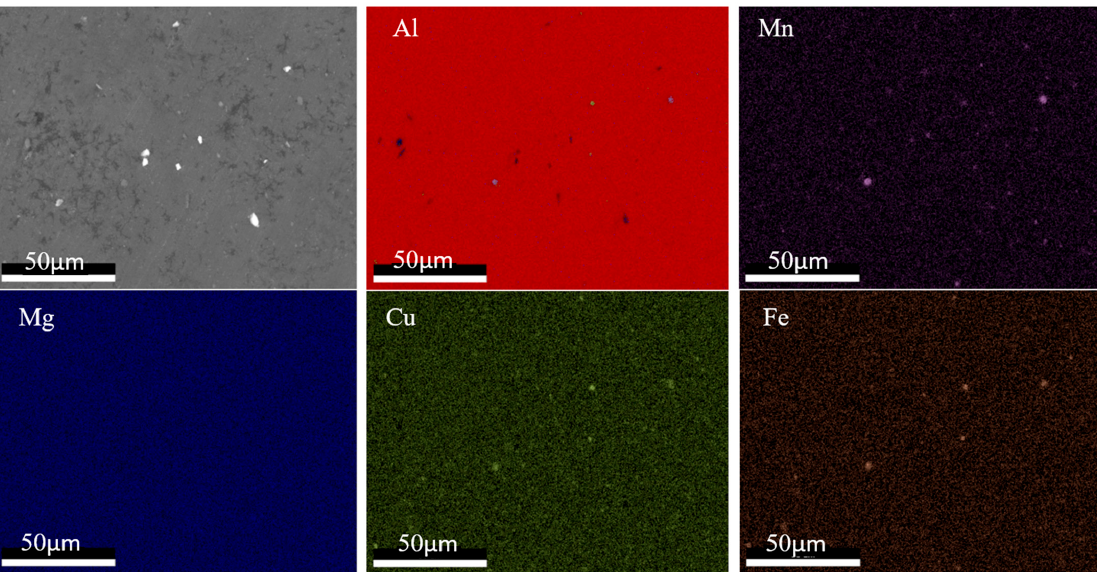
Figure 12. EDS mapping results showing the distribution of elements in the samples of the as- deposited Al2050